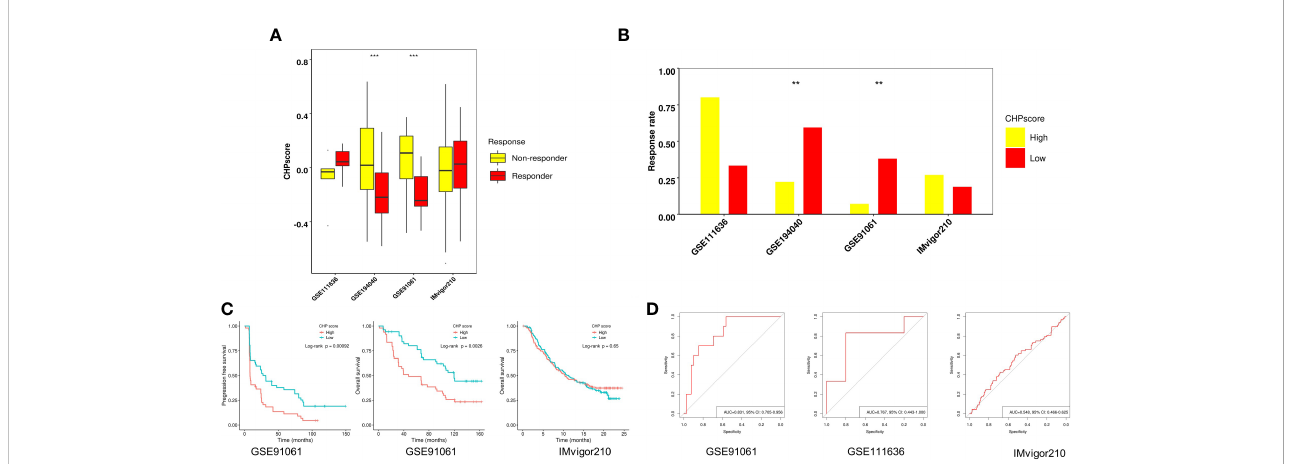
FIGURE 3 Role of CHP score in predicting the immunotherapy response in four GEO datasets. (A) The CHP score in responder and non-responder groups in four GEO datasets. (B) Respond rate in CHP score high and CHP score low groups in four GEO immunotherapy datasets. (C) K-M plot showing the PFS or OS of patients in two GEO immunotherapy datasets. (D) ROC curve indicates the ability of the CHP score to predict the immunotherapy response in three GEO datasets.